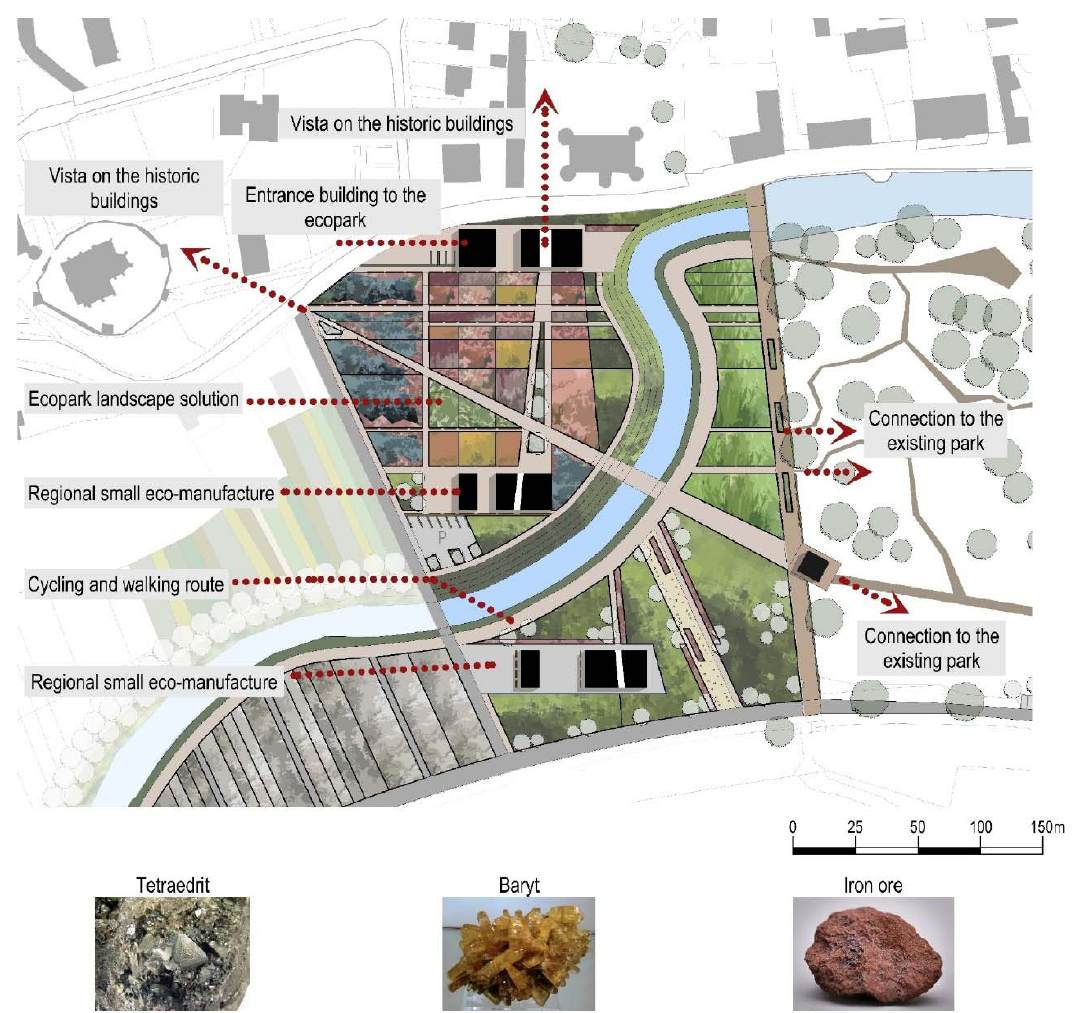
Figure 11. The concept highlighting the landscape and flora, Case Study 1b (author’s design studio, A. Rov ň anová).